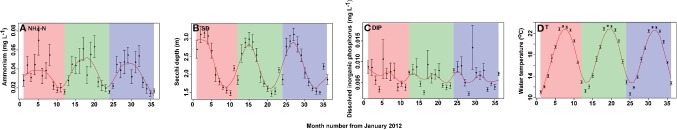
Monthly time series of values of physical and chemical parameters in Lake Erhai from January 2012 to December 2014. (A) ammonium (NH4-N), (B) Secchi depth (SD), (C) dissolved inorganic phosphorus (DIP), and (D) water temperature (T). Values are presented as the mean ± standard deviation (SD) among the 15 sites for each month. To detect the seasonality of environmental parameters, a locally weighted scatter smoothing function (Cleveland, 1981) was used to fit a smooth curve (span = 0.75) using month as the predictor variable.